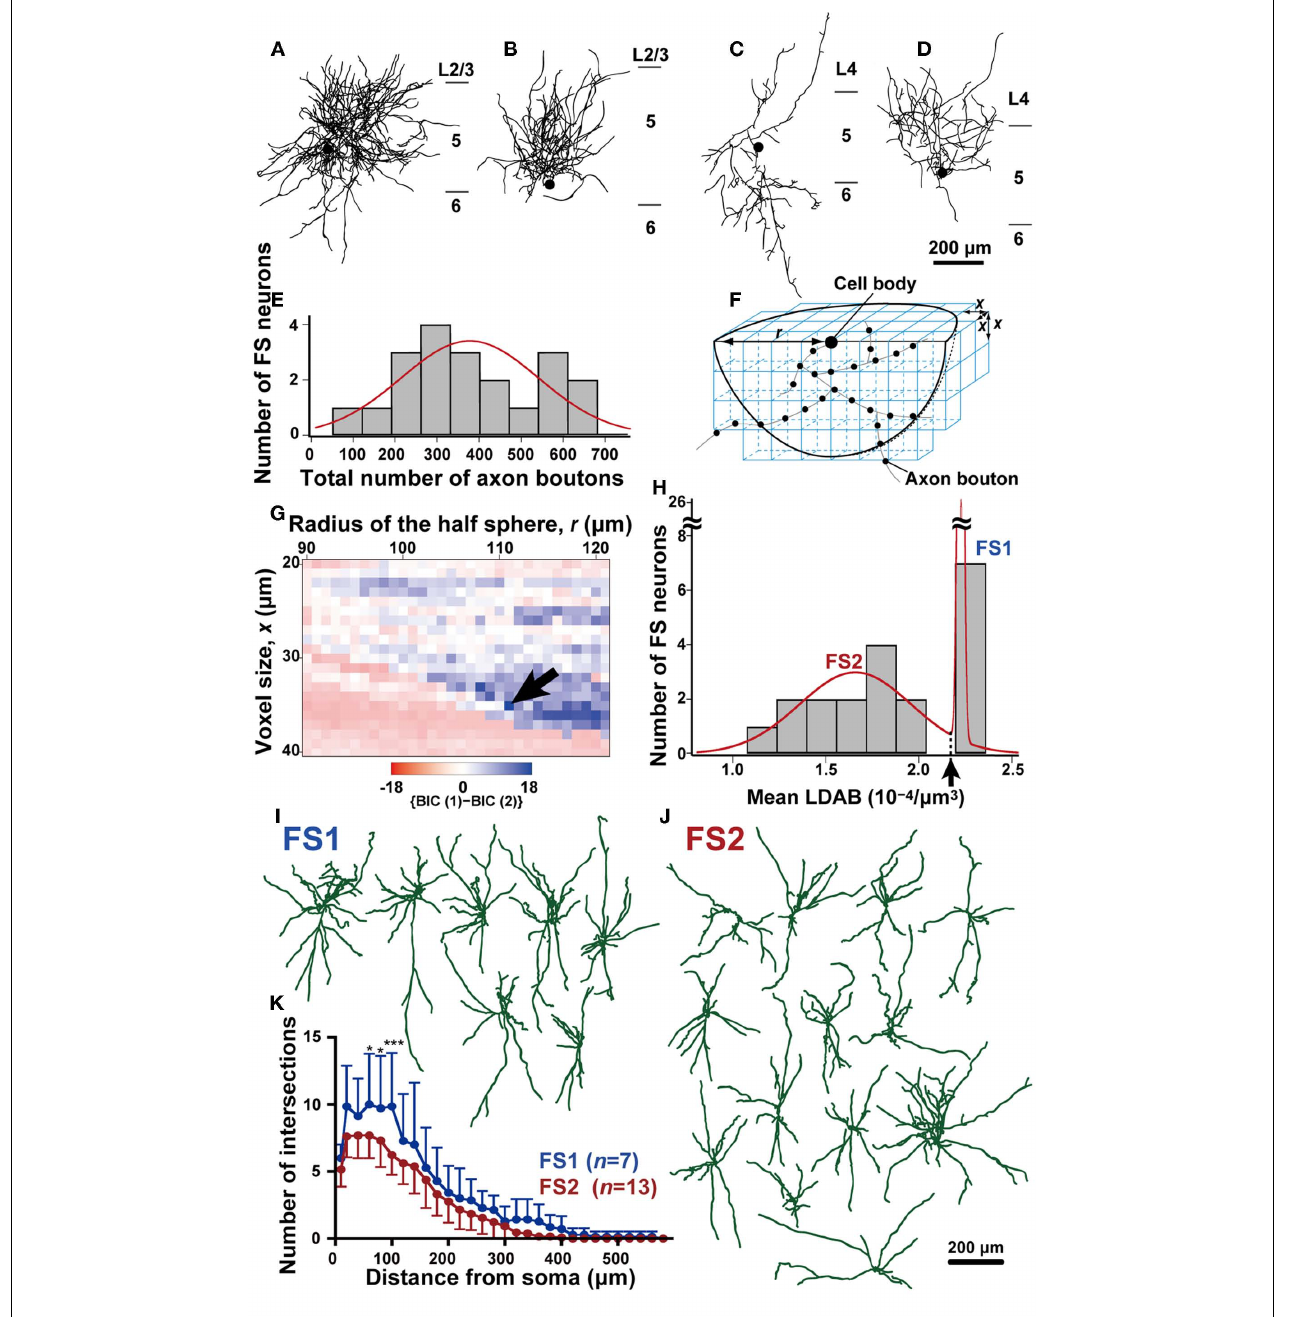
cell body in the 500- μ m-thick slice was divided into voxels with the size of x , and the mean LDAB was calculated as the average of axon bouton density of voxels that contained at least one bouton. (G) {BIC(1)-BIC(2)} values of fitting curves for the frequency histogram of L5 FS neurons against the mean LDAB. The {BIC(1)-BIC(2)} values was plotted with pseudocolor in a two-dimensional parameter space of radius r and voxel size x .The frequency histogram of FS neurons was fitted with a single Gaussian curve or with a mixture curve of two Gaussian distributions. Since smaller BIC indicates better fitting, blue points imply that the mixture curve of two Gaussian distributions better fits the histogram than a single curve. Arrow indicates the parameter